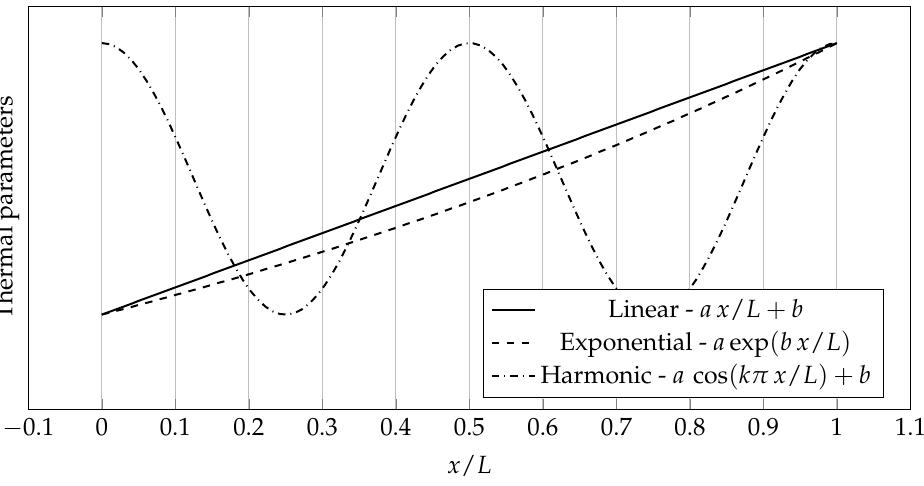
Figure 4. Distribution shapes of thermophysical parameters used in the calculations. The values of the coefficients appearing in the distributions shown in Figure 4 are as follows a = 1, b = 1.2, k = 4, L = 2 m. The constants a and b have appropriate units depending on the physical quantity